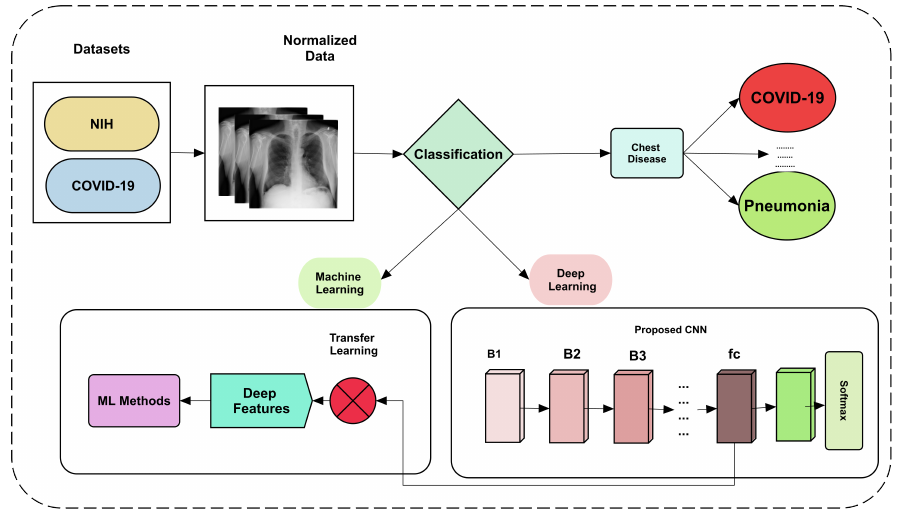
Figure 1. The proposed framework containing all steps for classification of chest